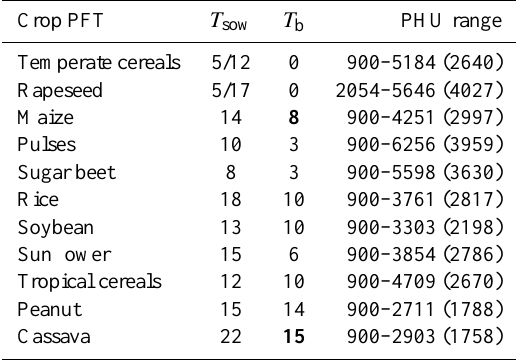
Table 1. PFT growing season parameters for crop PFTs used in this